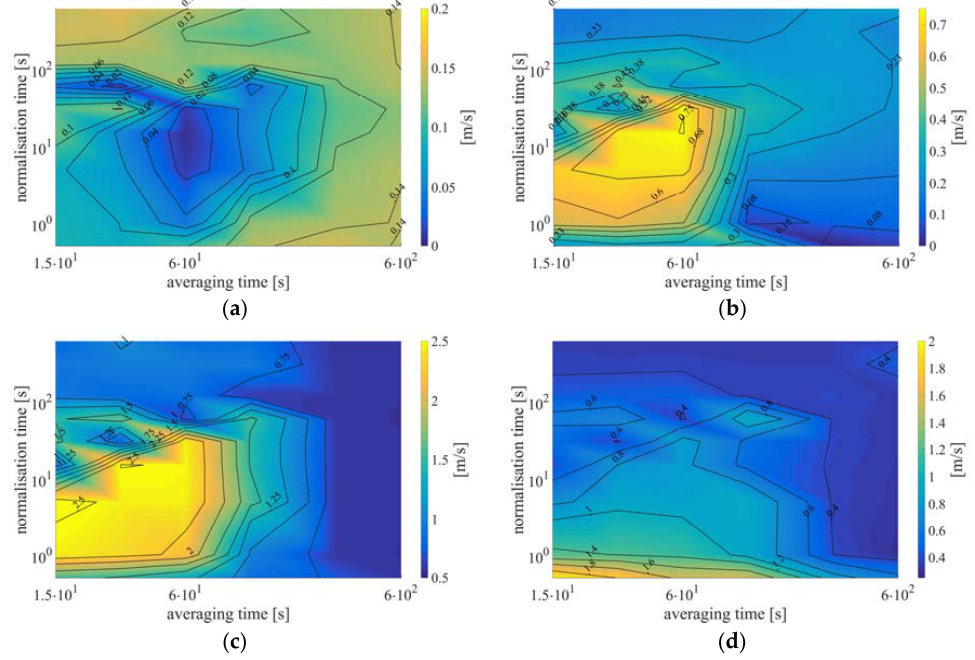
Figure A3. Visualisation of the influence of the normalisation time ∆ t and the averaging time ∆ T on the resulting error of staring mode LiDAR data from 04.01.2014 7:30 h (UTC) till 05.01.2014 7:30 h (UTC) from the Gaussian kernel based dynamic data filter. ( a ) Average velocity error, ( b ) average velocity standard deviation error, ( c ) RMS velocity error and ( d ) RMS velocity standard deviation error.